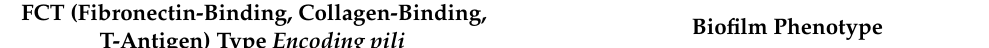
Representation of S. pyogenes pilus structure encoding in the Fibronectin-Binding, Collagen-Binding, T-Antigen (FCT) genomic region, and its e ff ect on biofilm-forming capacity. FCT (Fibronectin-Binding, Collagen-Binding, T-Antigen) Type Encoding